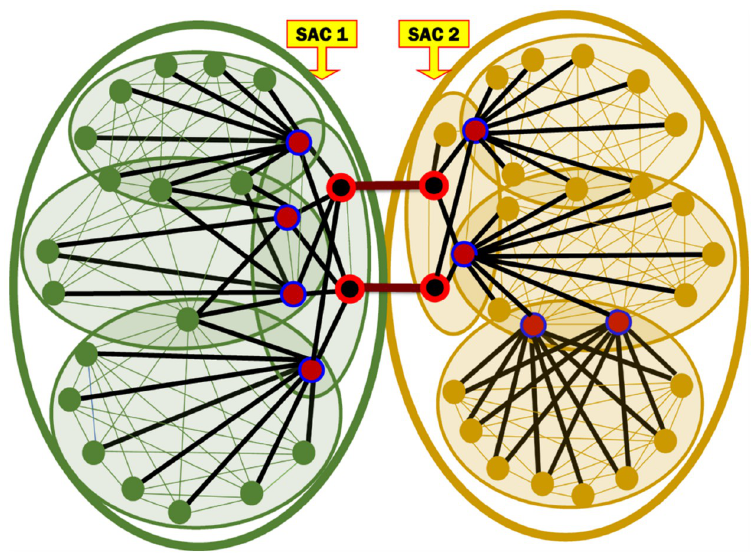
Fig 4. An excerpt from Fig 2 shows SACs 1 and 2 and their two Association Edges to illustrate the factors that impact the BI score.